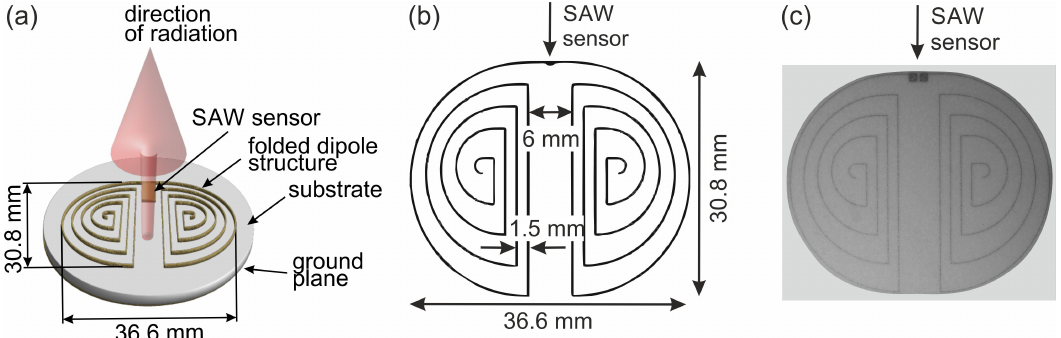
Figure 1. ( a ) Visualization of the principle of a folded dipole antenna structure on a substrate (not to scale). ( b ) Schematic drawing of the optimized antenna and ( c ) photo of a realized antenna